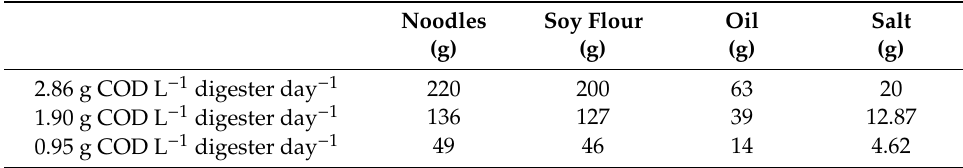
Table A1. Additional amounts of the used substrates in di ff erent